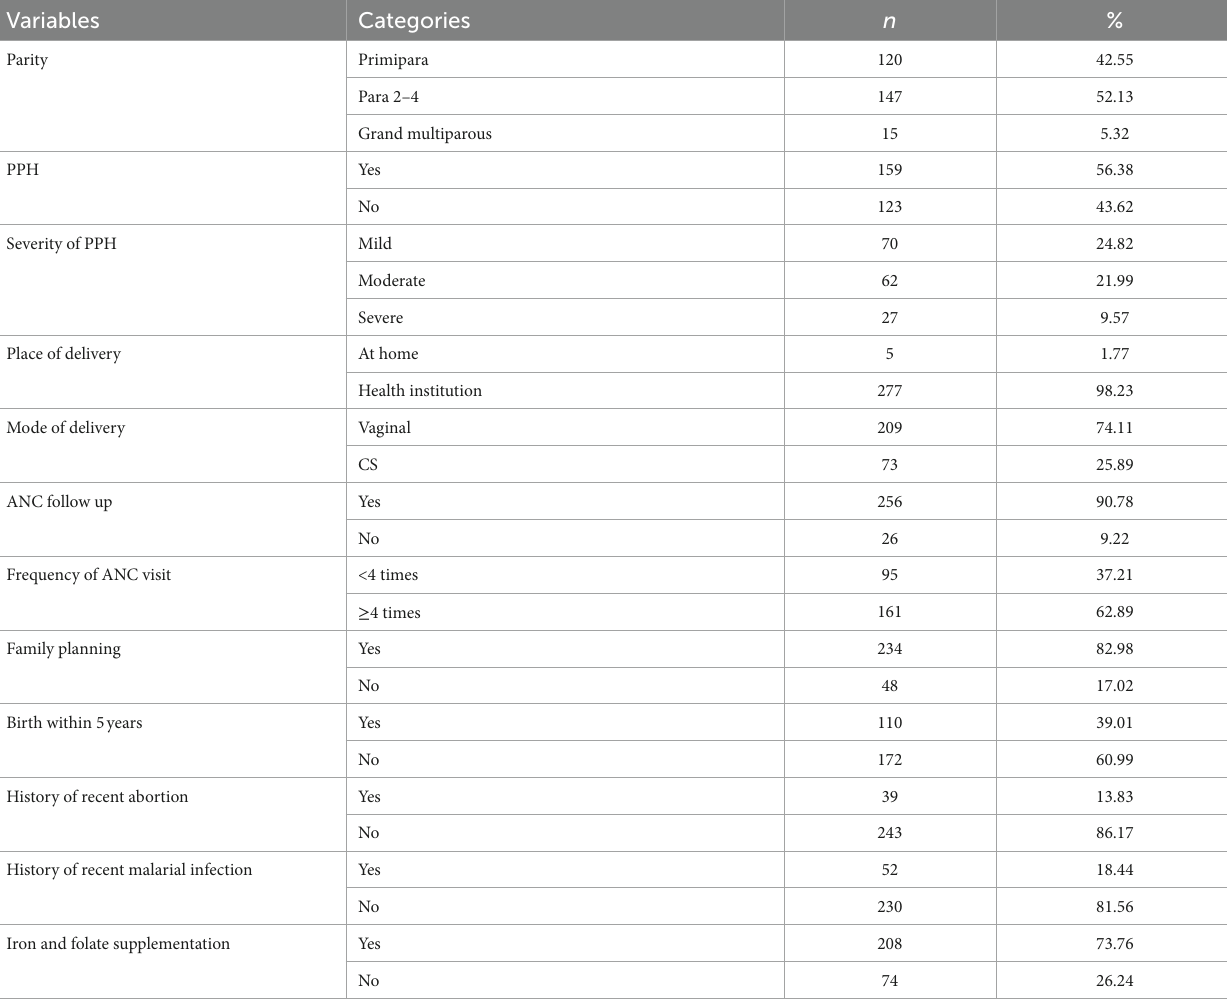
TABLE 2 Obstetric and clinical characteristics of postnatal women in Gondar town, Northwest Ethiopia, 2021 ( n = 282).